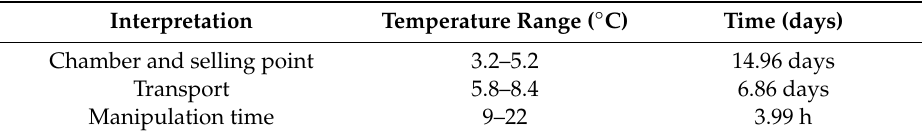
Table 4. Pumpkin time range interpretation.